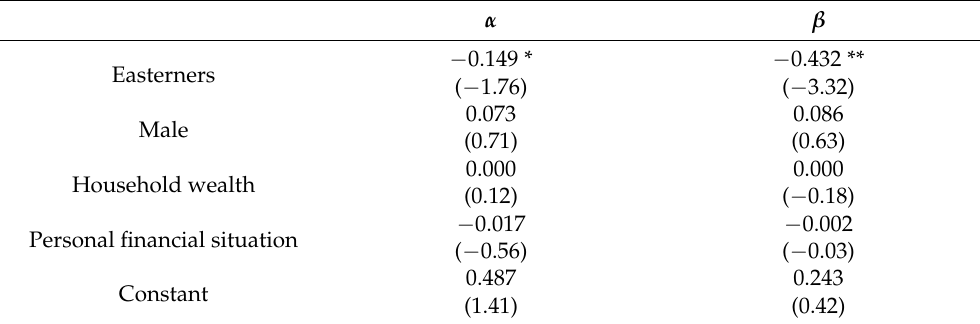
Table 3. Analysis of risk and ambiguity attitudes, including socioeconomic factors as